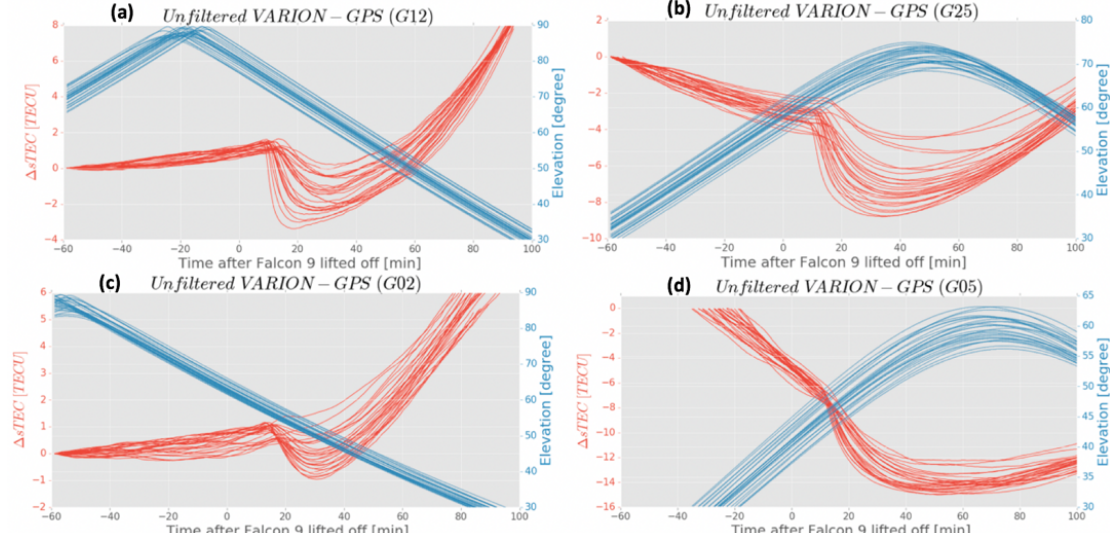
Figure 3. Unfiltered VARION-GPS δ sTEC solutions ( red curves ) for satellites G12, G25, G02, and G05. The blue curves show the elevation angle for each satellite-receiver link. The δ sTEC solutions show a lower high-frequency noise compared to the VARION-GEO solutions (Figure 2). However, the higher long period trends in the unfiltered VARION-GPS solutions do not allow fully capturing the ionospheric response to the rocket